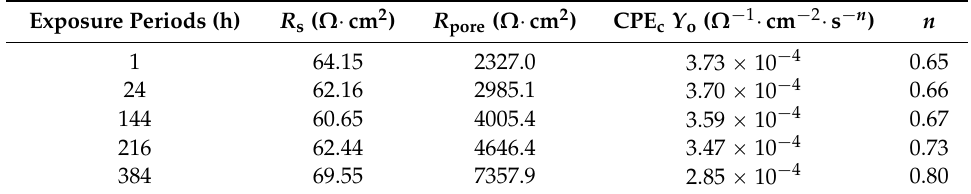
Table 5. Electrochemical parameters of Al coating extracted after the fitting of EIS data in a constant phase element (CPE) model with exposure periods in SAE J2334